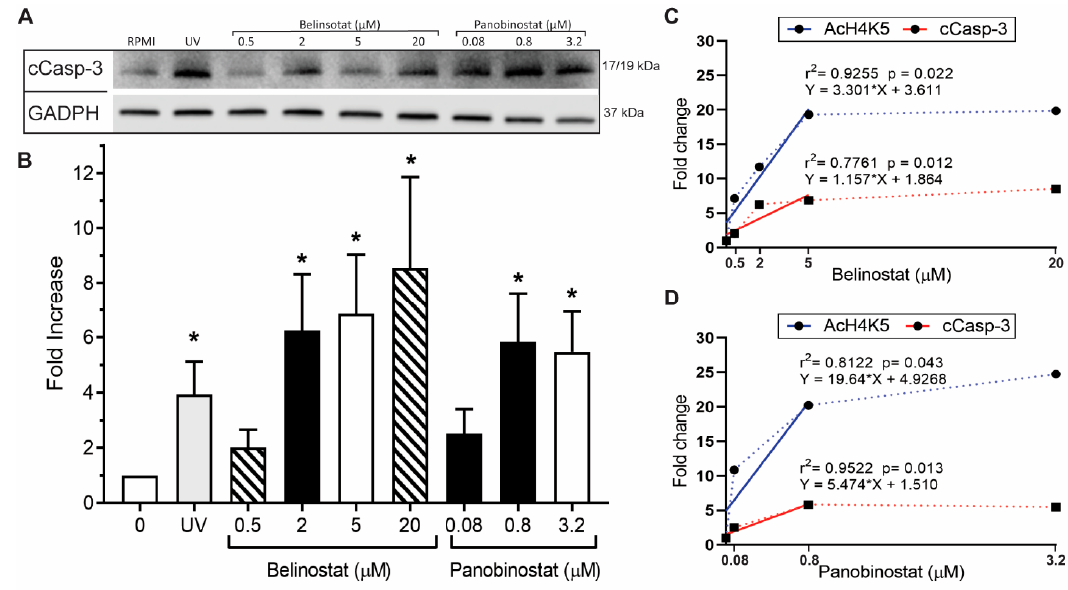
Figure 6. Western blots confirm that HDAC inhibitors induce apoptosis in neutrophils. ( A ) Neutrophils were treated with RPMI (negative control), positive control (ultraviolet (UV); 0.24 J / cm 2 ) or HDAC inhibitors (0.5, 2, 5 and 20 µ M belinostat; 0.08, 0.8 and 3.2 µ M panobinostat) for 90 min. An equal amount of lysates from each condition were separated by polyacrylamide gels, transferred onto a membrane and specific proteins were immunodetected (GADPH for loading control and cCasp-3 for apoptosis). ( B ) The densitometry analyses show a dose-dependent increase in apoptosis when neutrophils were treated with HDAC inhibitors. The values were normalized to the negative control values in each experiment. ( C,D ) Regression analysis of histone acetylation determined by Western blots (AcH4K5, Figure 2; cCasp-3, Figure 6) show that HDACis induce histone acetylation and apoptosis at a significant rate when neutrophils were treated with belinostat ( C ) or panobinostat ( D ) at concentrations of ≤ 5 µ M or ≤ 0.8 µ M, respectively. AcH4 and cCasp-3 levels plateau when cells are treated with higher concentrations of HDACis. The equations of regression lines, r 2 values and p -values are indicated on each panel. All data are presented as mean ± SEM; n = 3-4; *, p < 0.05 compared to respective controls. See Supplementary Figure S6 for the full Western blot.